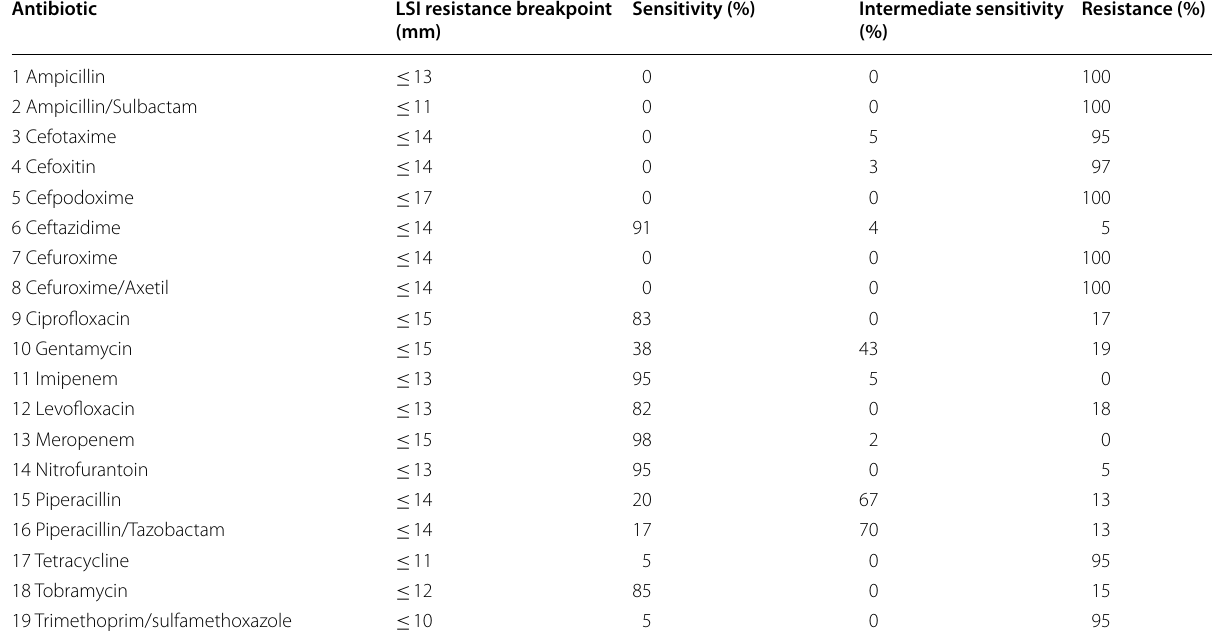
Table 1 Antibacterial sensitivity profile of the MDR clinical P. aeruginosa Antibiotic